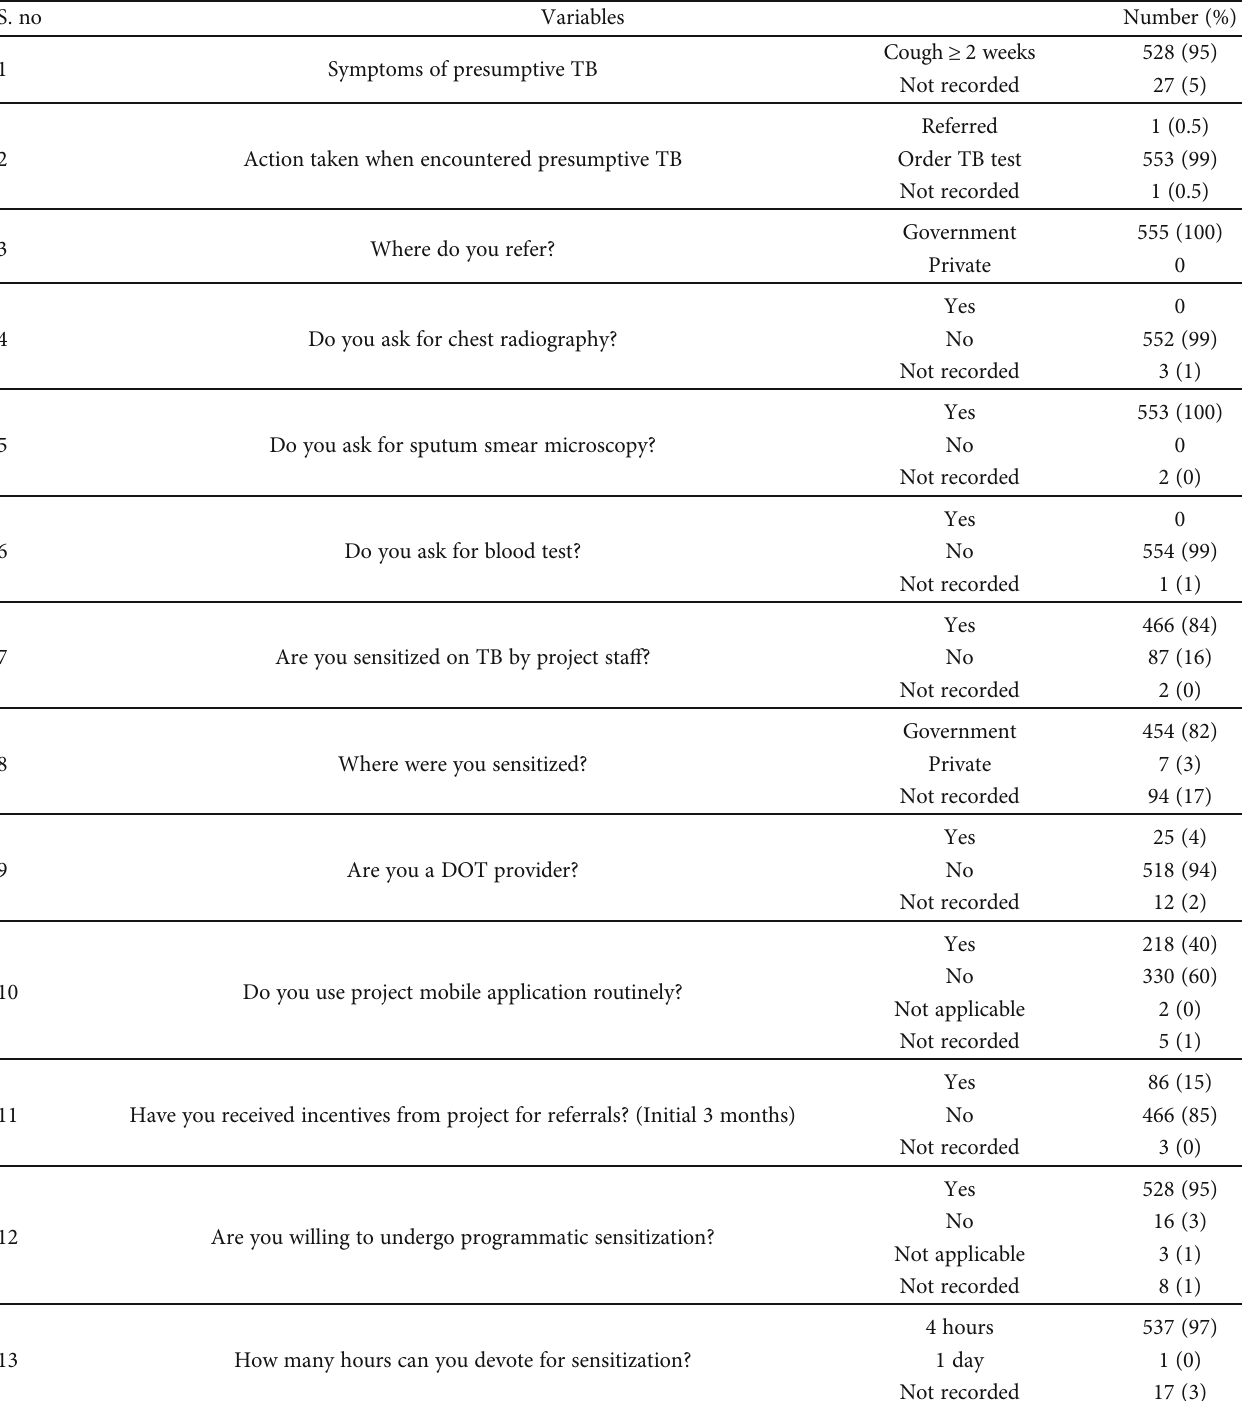
Table 2: TB management practices of Informal providers at the time of involvement under RIPENED project, Telangana State, India, during 2018-19 ( N = 555